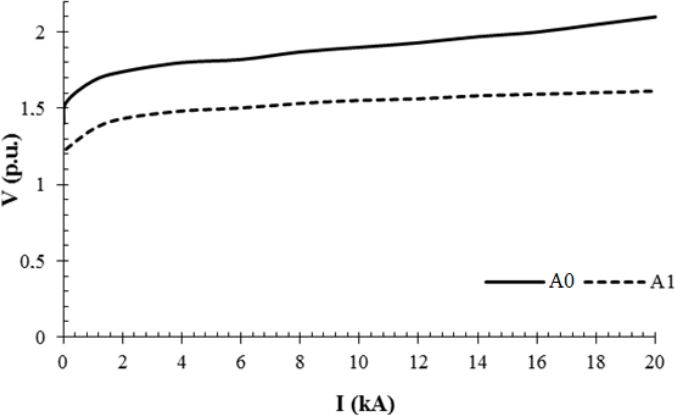
Figure 4. Voltage–current characteristics of the non-linear resistances A 0 and A 1 [8].